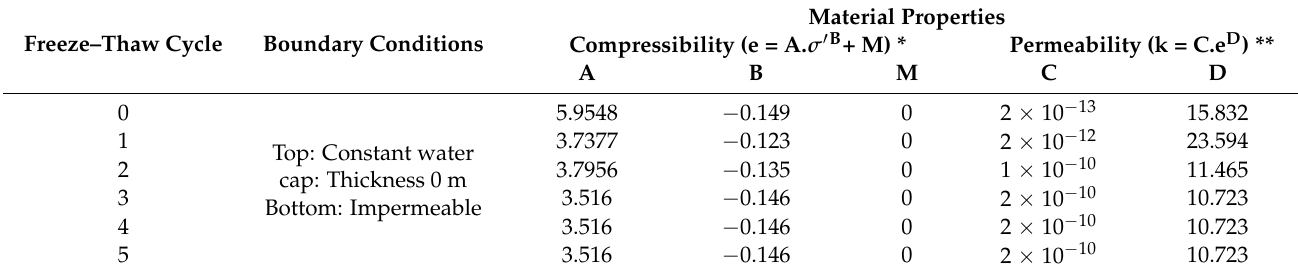
Table 2. Boundary conditions and summary of parameters for the FSConsol models.